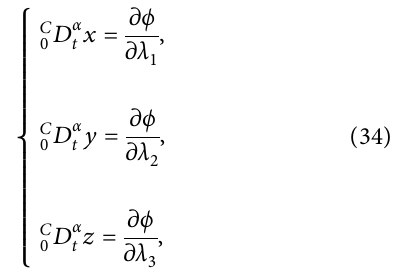
Figure 15: Dynamics of z ( t ) where a � 0 . 1 , b � 0 . 1 , c � 0 . 1 , e � 0 . 3 , f � 0 . 2 , h � 0 . 3 , i � 0 . 2 , C � 0 . 01 , A � 0 . 02 , andA A 1 2